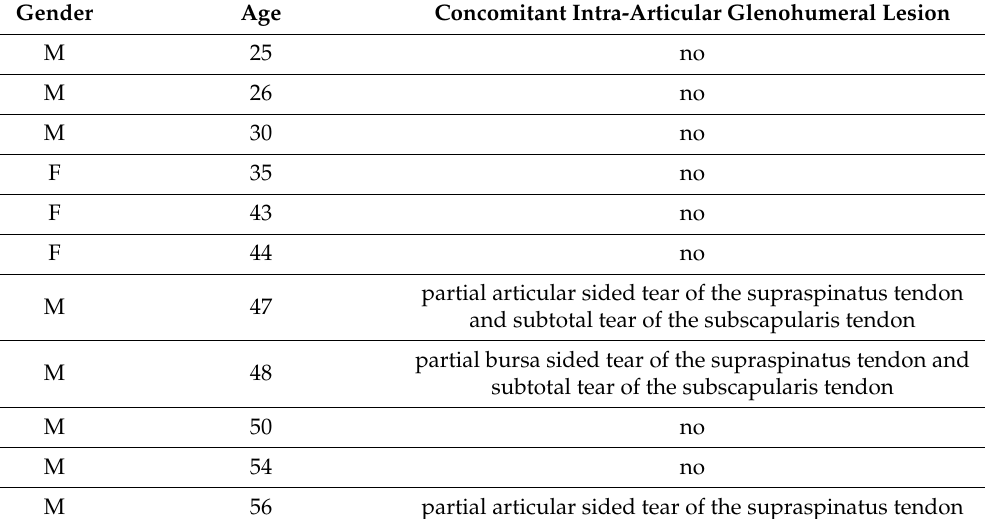
Table 1. Patients’ age and the presence of a concomitant intra-articular injury reveal a weak correlation. Gender